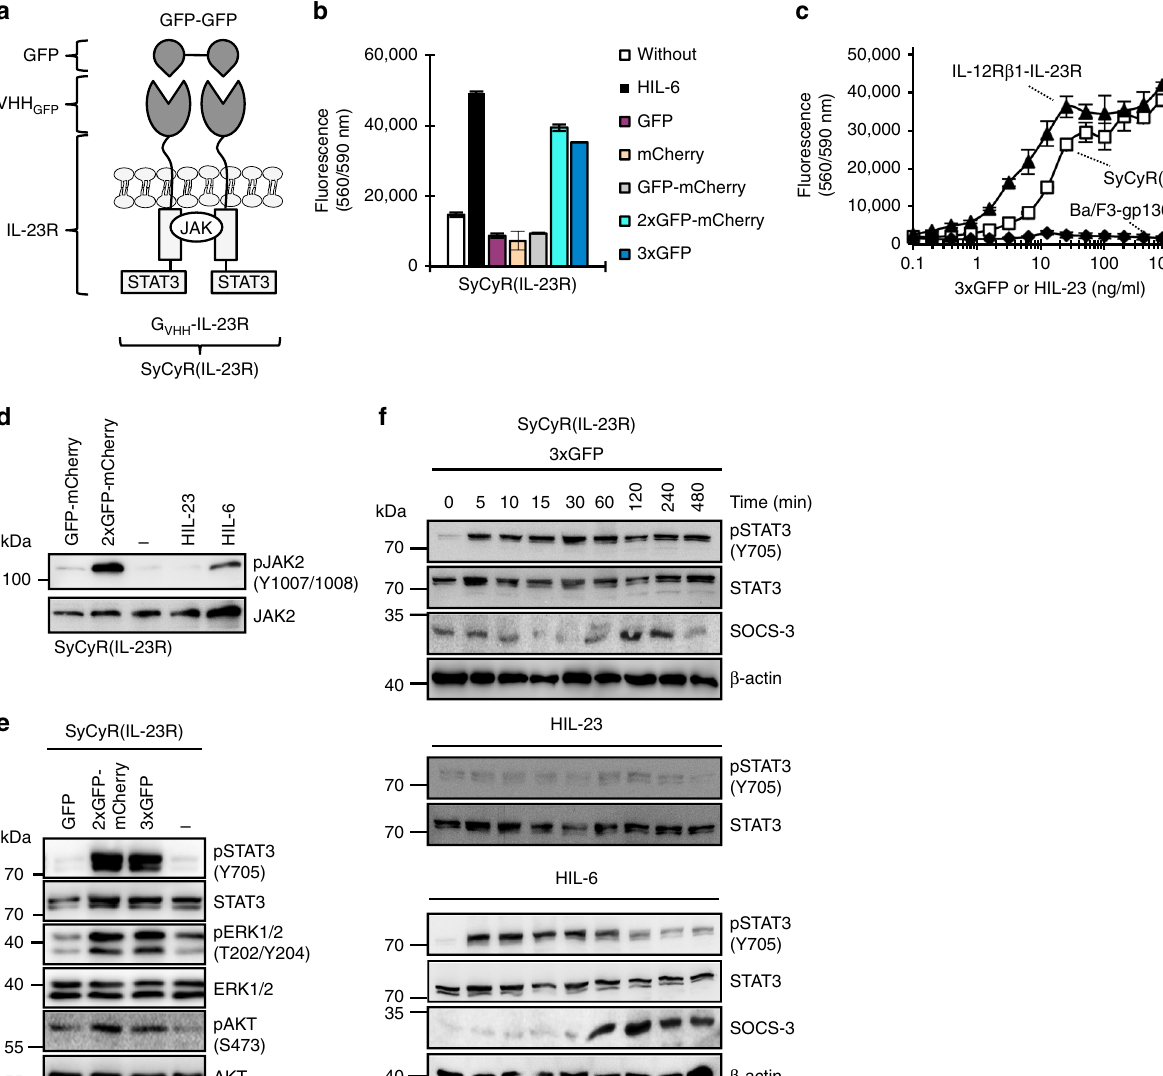
obtained from Ursula Klingmüller (DKFZ, Heidelberg, Germany) 43 . Ba/F3-gp130 cells with murine IL-12R β 1 and murine IL-23R have been described previously 18 . All cell lines were grown in Dulbecco ’ s modi fi ed Eagle medium (DMEM) high- glucose culture medium (GIBCO ® , Life Technologies, Darmstadt, Germany) sup- plemented with 10% fetal calf serum (GIBCO ® , Life Technologies, Darmstadt, Germany), 60 mg/l penicillin and 100 mg/l streptomycin (Genaxxon Bioscience GmbH, Ulm, Germany) at 37 °C with 5% CO 2 in a water saturated atmosphere. Ba/ F3-gp130 cells were maintained in the presence of Hyper-IL-6 (HIL-6), a fusion